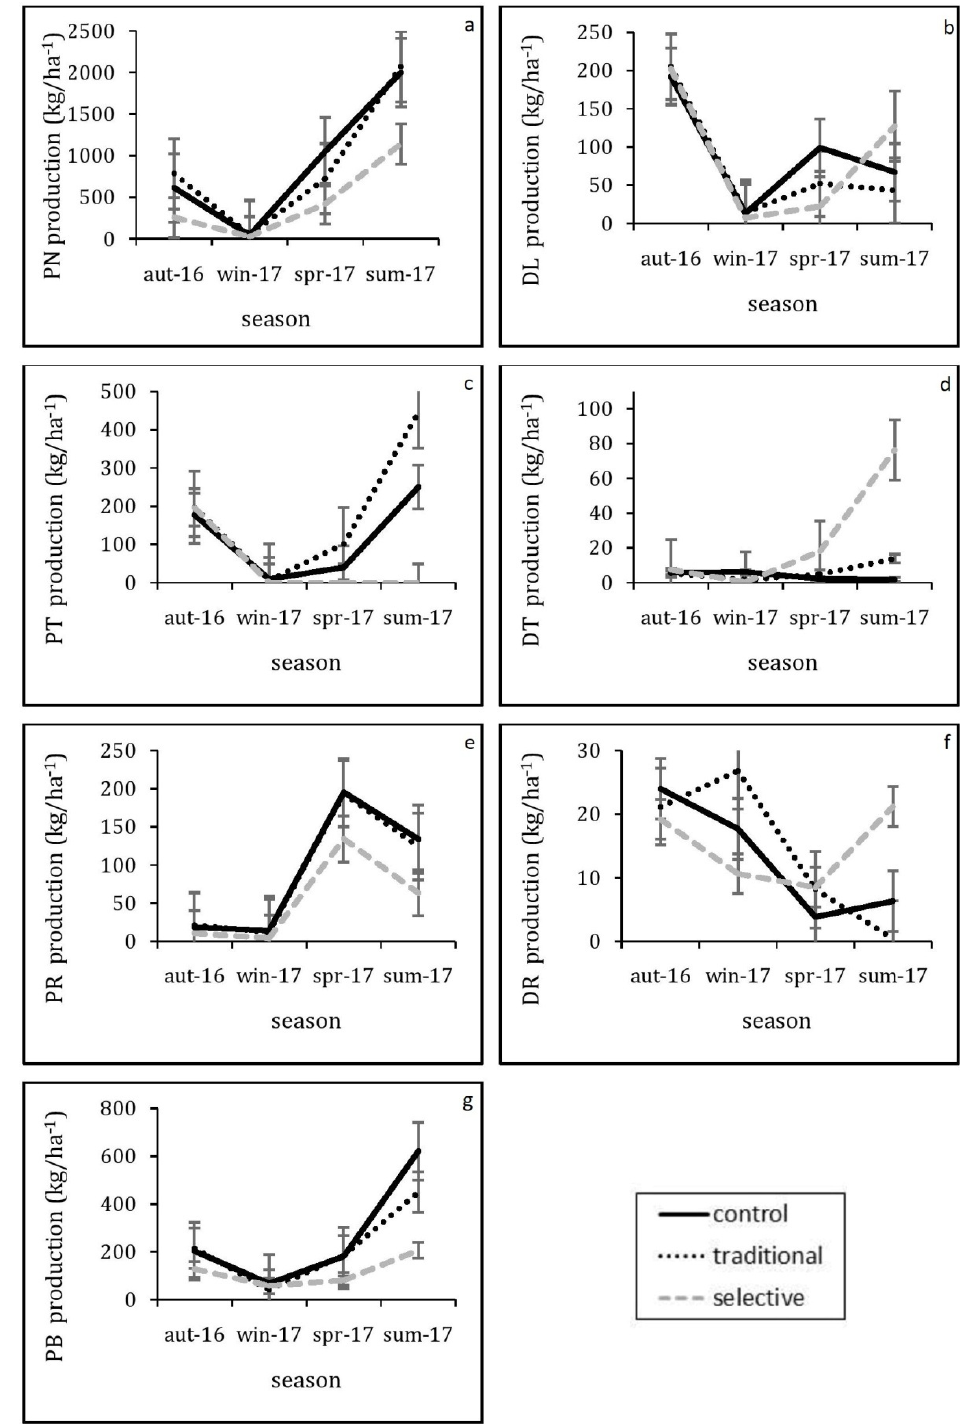
Figure 2. Seasonal pattern (aut: autumn, win: winter, spr: spring, sum: summer) of litterfall fractions over the study period (16 October until 17 September). ( a ) PN pine needles, ( b ) DL deciduous leaves, ( c ) PT pine twigs, ( d ) DT deciduous twigs, ( e ) PR pine reproductive, ( f ) DR deciduous reproductive, ( g ) PB pine bark. Each data point represents the mean of the three replicates for each treatment (Control, Traditional and Selective). Error bars indicate the standard error.